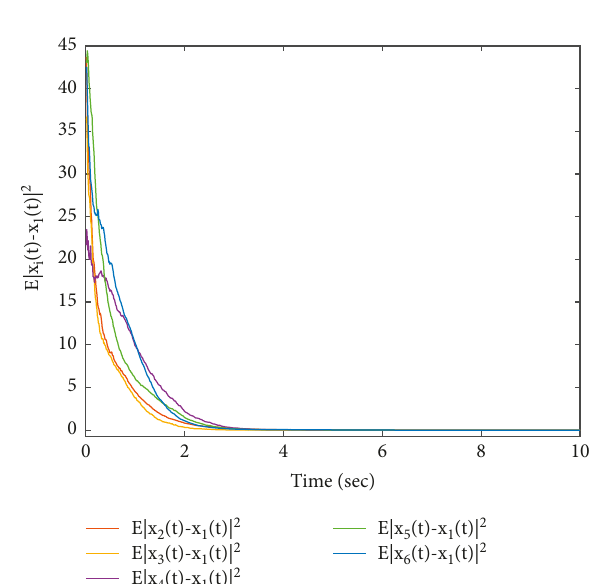
Figure 3: Mean square errors E | x